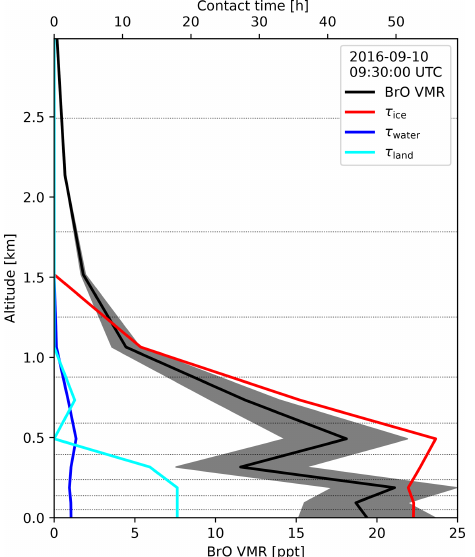
Figure 4. Example for a vertical profile of BrO at NM (black line, bottom axis) together with the contact times (top axis) of the air parcels over ice (red), open water (blue), and land (cyan) on 10 September 2016 at 09:30UTC. The grey-shaded area shows the random error in the BrO profile. Dotted horizontal lines indicate the retrieval layer boundaries.